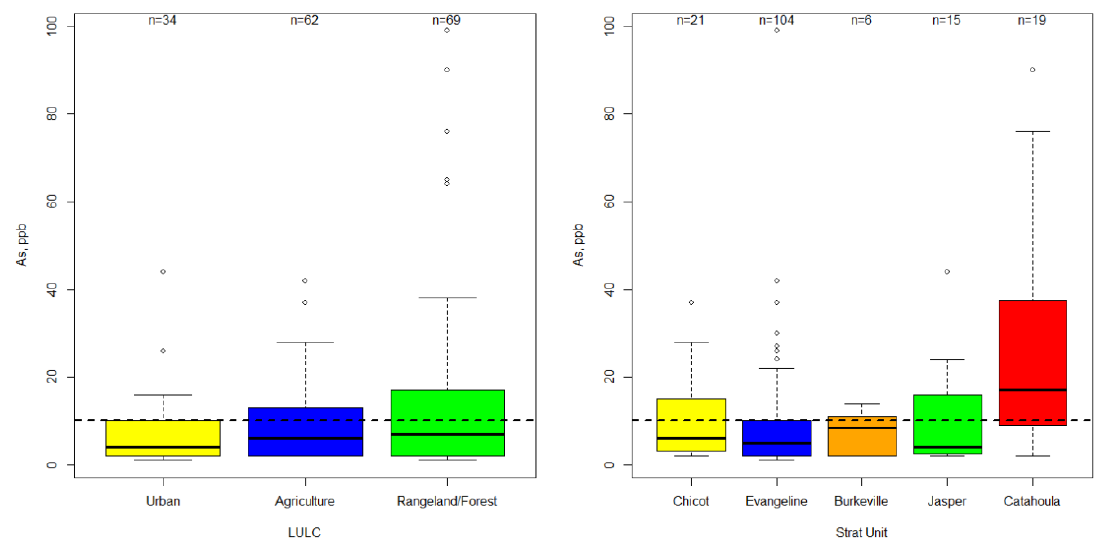
Figure 3. Distribution of arsenic by LULC and stratigraphic unit (dotted line shows the maximum contaminant level (MCL)).